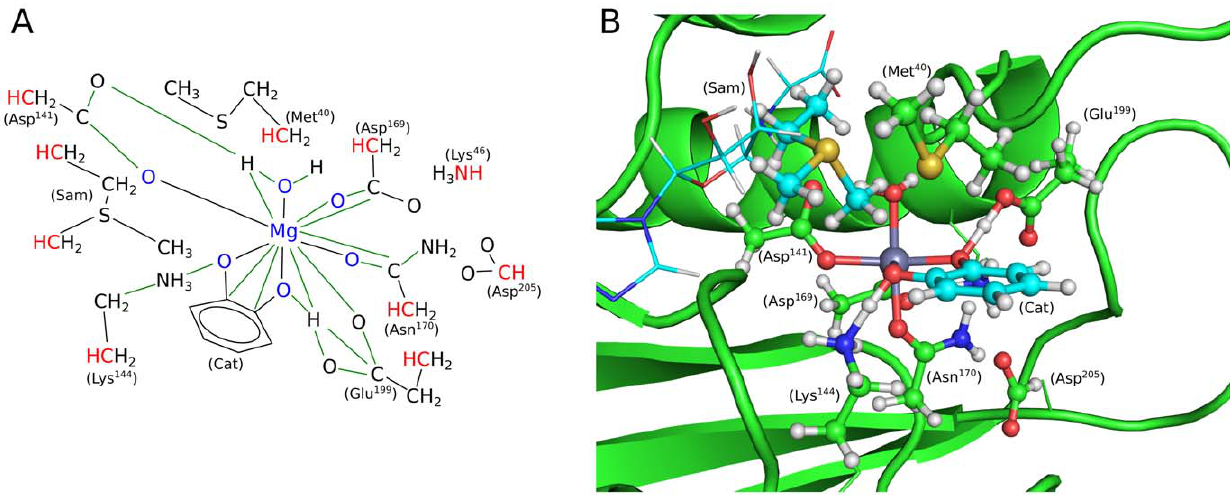
Figure 2. QM/DMD setup for COMT. A) Topological representation of the system as treated during the QM calculations ( QM-DMD domain). The color red marks the atoms whose positions are frozen during QM calculations, to retain the structure imposed by the rest of the protein. With the blue color, the atoms in the QM-only domain are marked. Green lines show additional constrains that are imposed during the DMD simulation, to retain the chemistry determined at the QM level of theory. B) QM-only domain embedded in the protein. atomsbridgingthe QM-DMD regionwiththerestoftheproteinwere